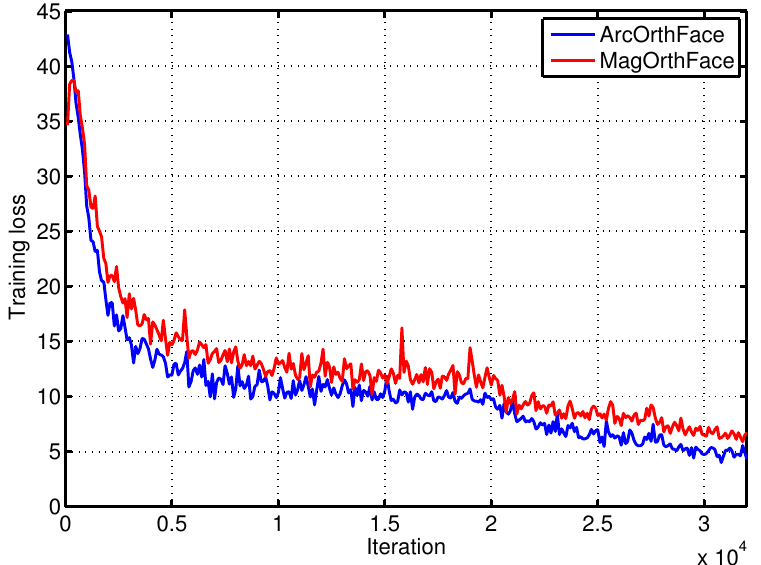
Figure 4. Training loss of the new loss functions combined with the Orthant loss